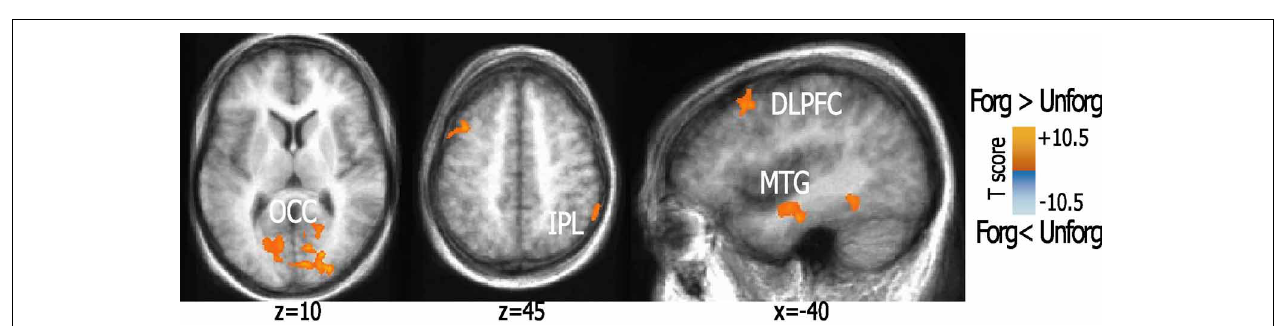
FIGURE 1 | Activation patterns elicited during the response condition as compared to pre-hurtful and hurtful conditions. The figure shows brain areas active during forgiveness and unforgiveness as compared to pre-hurtful and hurtful scenarios.